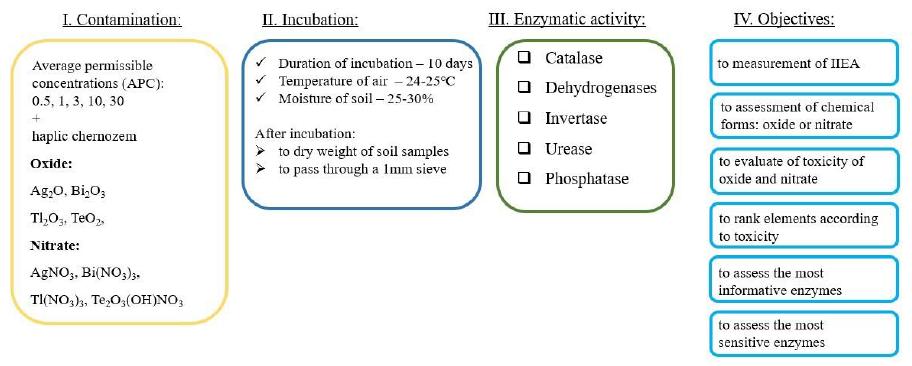
Figure 1. Scheme of a model experiment.